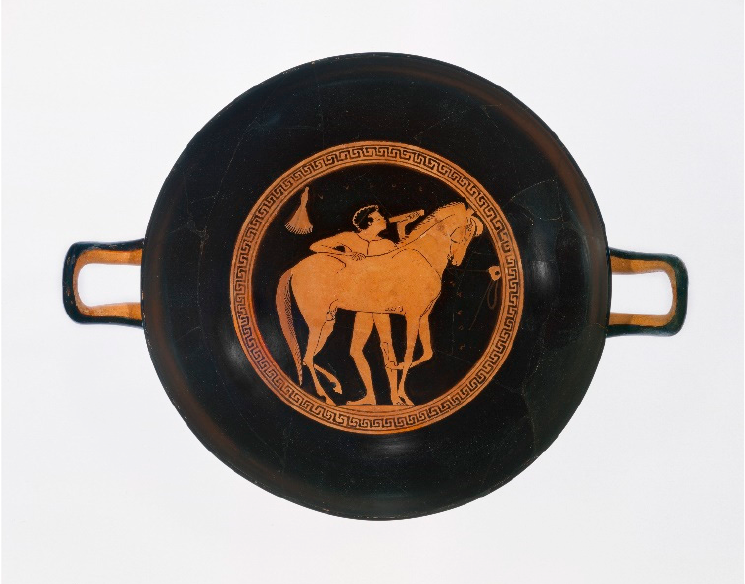
Figure 8. Kylix attributed to Onesimos. Ca. 490 BCE. Metropolitan Museum of Art. Gift of the Norbert Schimmel Trust, 1989. Inv. no. 1989.281.71. The walk is typically denoted through the lifting of a front leg, and flexion of some sort in a hind limb. The motion can be subtle, as with the bronze harnessed horse from Olympia, where the forward movement is indicated by the placement of the legs, rather than the raising of the hooves (Olympia B 1741), or the marble statue of the forepart of